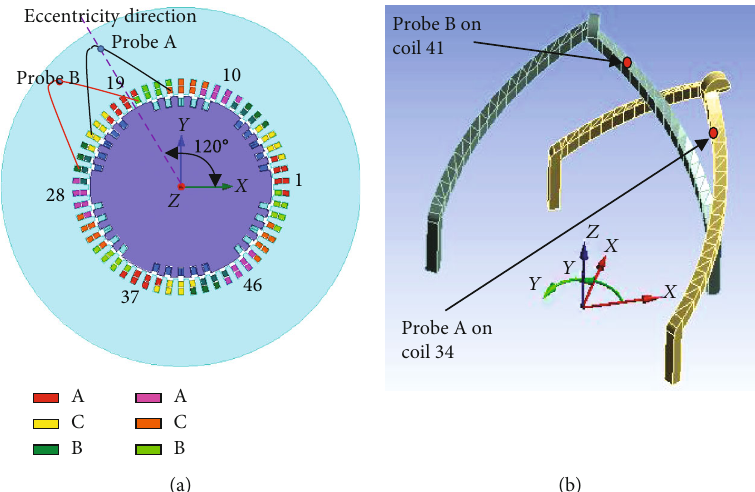
Figure 10: Probe positions of radial acceleration: (a) in experiment and (b) in